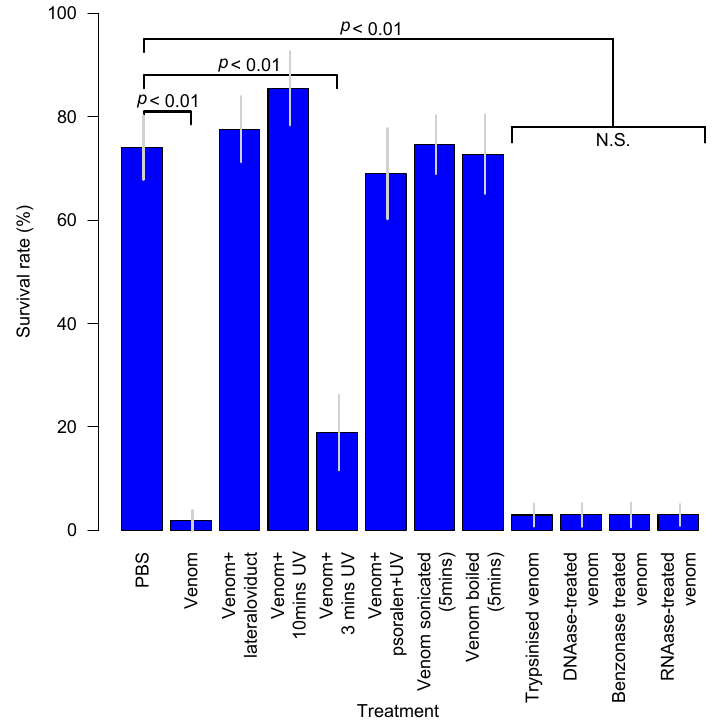
Figure 6. Effects of Asobara japonica venom and treated venom on the survivorship of D. melanogaster larvae one day after injection. Enzymatic treatments were conducted for 2 h at 25 °C (trypsin) or 37 °C (the others). (Source: redrawn based on [149] under the terms of Creative Commons Attribution Licence CC-BY 4.0 via PLoS ONE ). N.S.: not